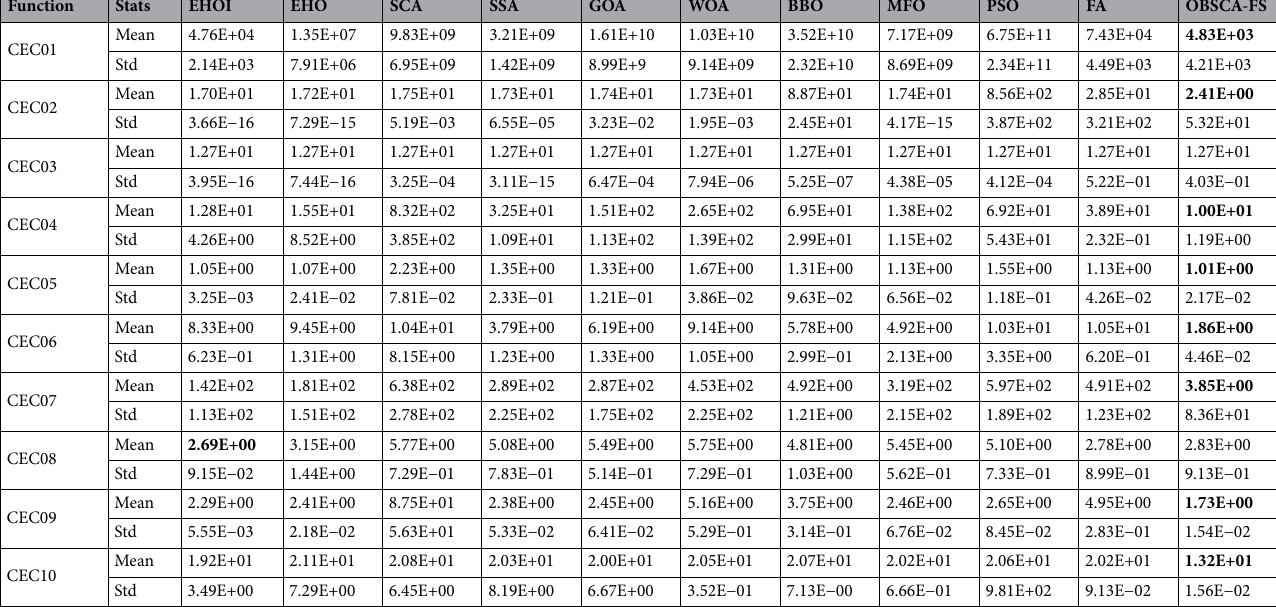
Table 2. Result comparison of different well-known metaheuristics on CEC2019 benchmark